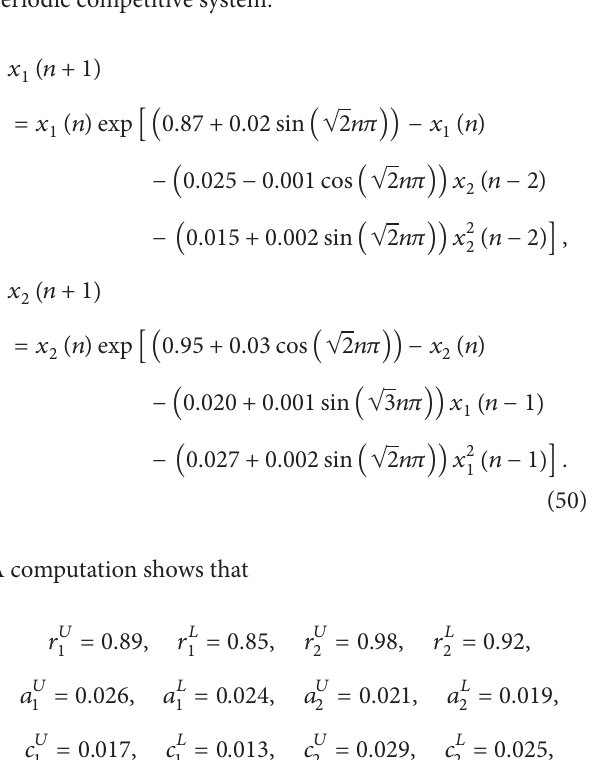
(𝑛) with initial values 𝑥 ∗ (−2) = 0.85 , 𝑥 ∗ (−1) = 0.80 , and 𝑥 ∗ (0) = 0.79 for 𝑛 ∈ [0,100] 2 2 2 2